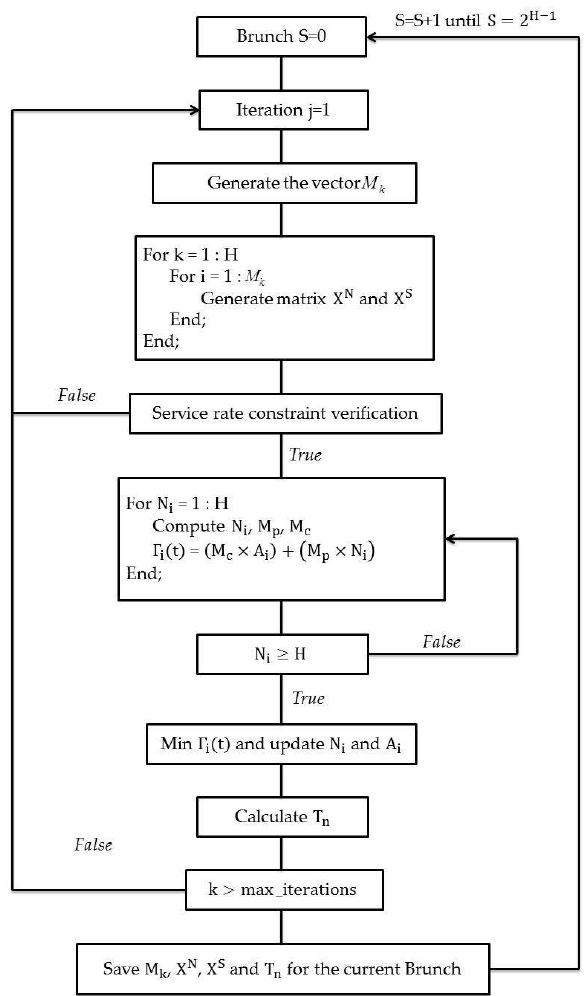
Figure 3. Steps of the resolution approach.